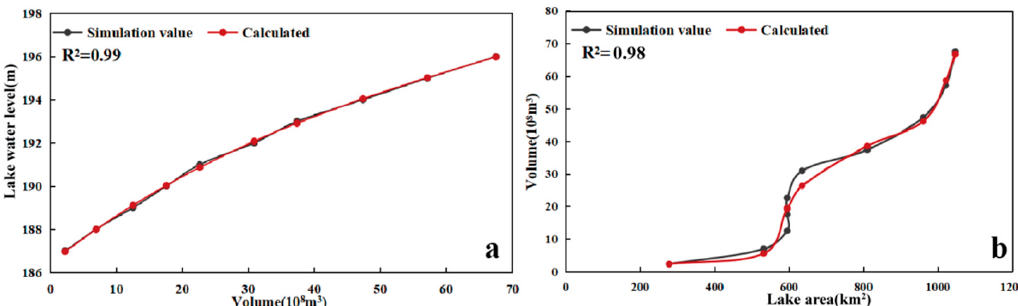
Figure 9. Fitting of the lake water level-water volume and lake water area-water volume relationships. ( a ):The fitting results of lake water volume and water level; ( b ):The fitting results of lake water area and water volume. Table 6. Fitting model of the lake water level-water volume and lake water area-water volume relationships.